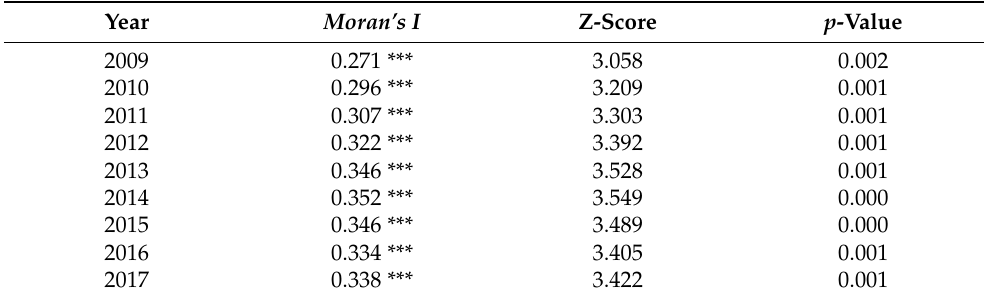
Table 3. Value of the Global Moran’s I of provincial PCTLA in China (2009–2017).